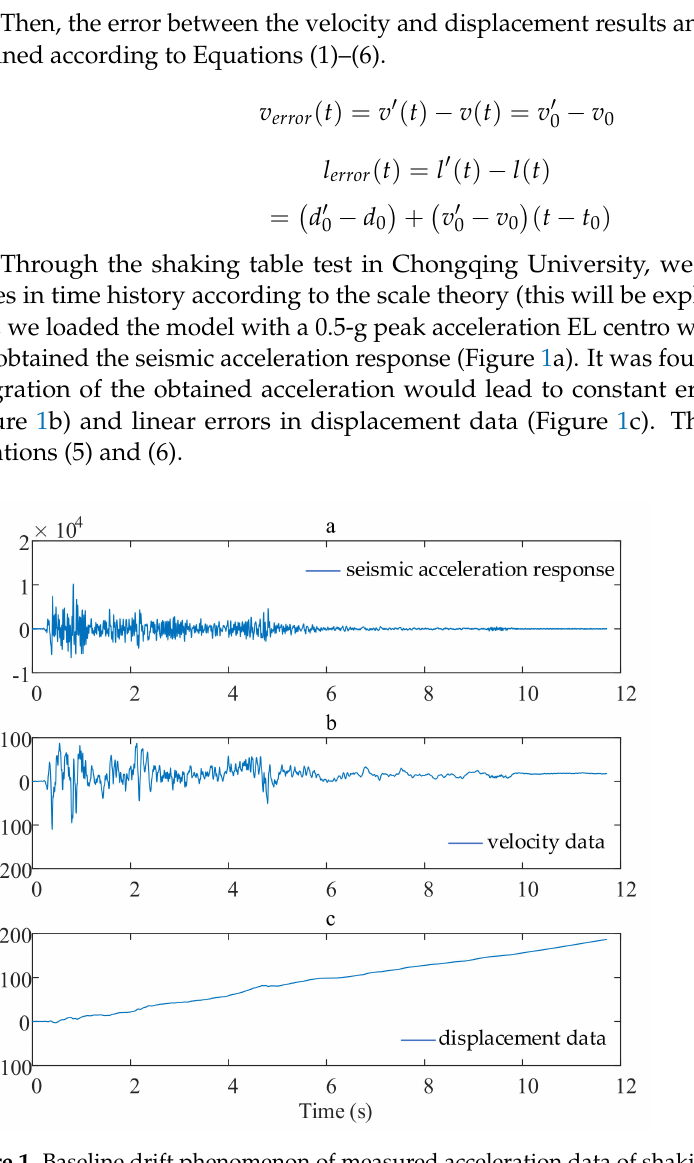
Figure 1. Baseline drift phenomenon of measured acceleration data of shaking table: ( a ) the seismic acceleration response; ( b ) velocity data; ( c ) displacement